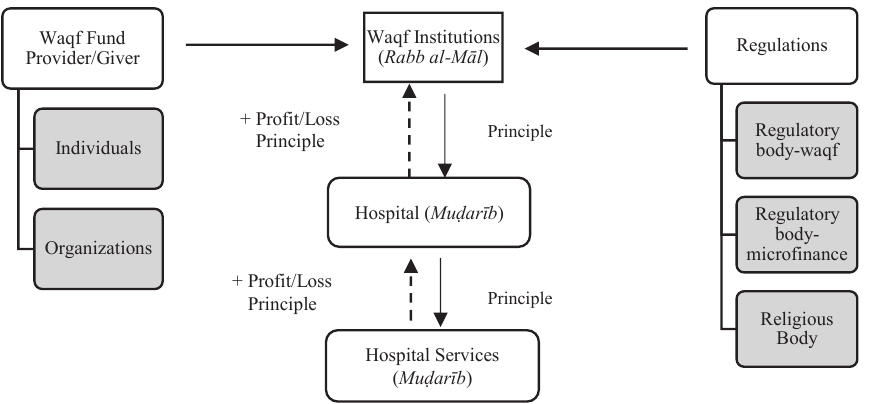
Figure 3. Two-tier mud. (cid:1)